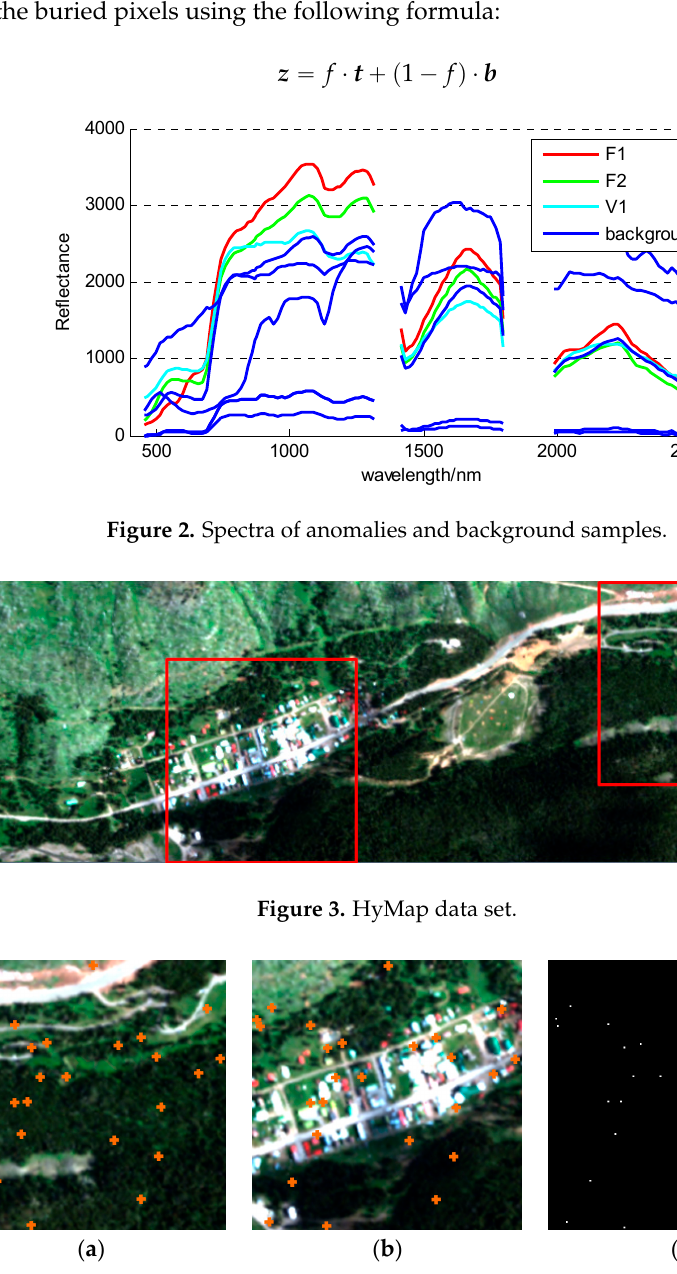
Figure 4. Sub-images with: ( a ) simple background; ( b ) complex background; and ( c ) ground-truth.